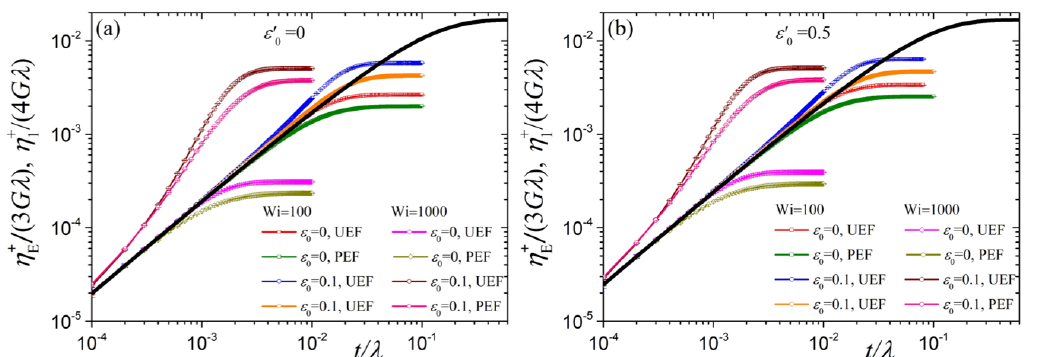
( ˙ (cid:101) , t ) /4 G λ (denoted as PEF in the legends) and 1 = 0, ( b ) ε (cid:48) = 0 0